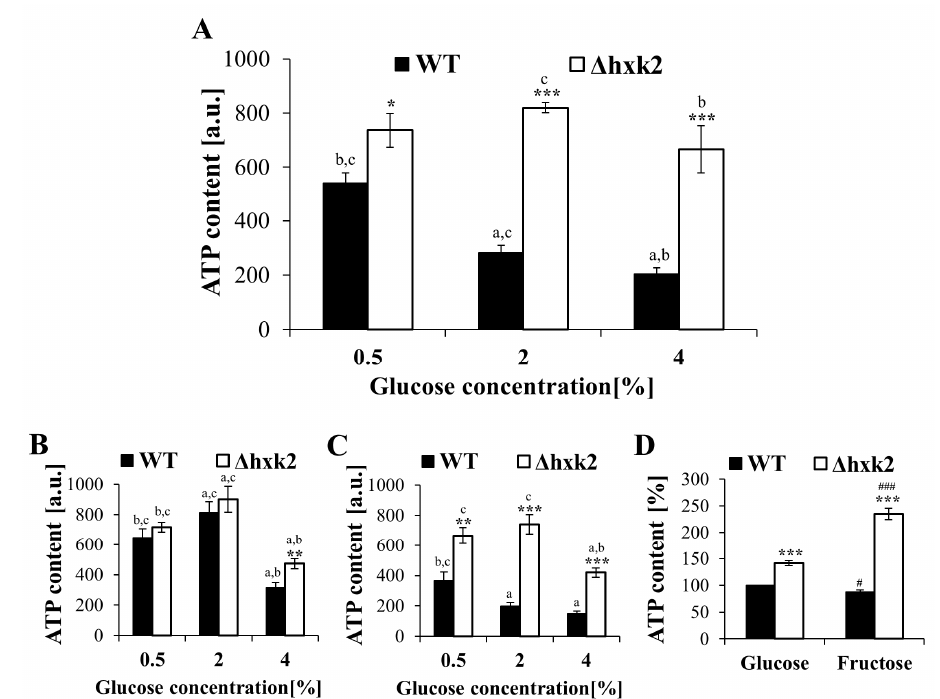
Figure 2. ATP content of yeast cells cultured in different metabolic conditions. ( A ) ATP content determined during exponential phase of growth, ( B ) ATP content determined after depletion of glucose in the medium and diauxic shift, ( C ) ATP content determined in respiratory-deficient (rho 0 ) yeast cells during exponential phase of growth, ( D ) comparison of ATP in yeast cells cultured in medium with glucose or fructose used in the same 2% concentration. The results are presented as mean ± SD from three independent experiments. * p < 0.05, ** p < 0.01, *** p < 0.001 as compared to the WT strain; # p < 0.05, ## p < 0.001 as compared to the medium with glucose; a—different to medium with 0.5% glucose, b—different to medium with 2% glucose, c—different to medium with 4% glucose.